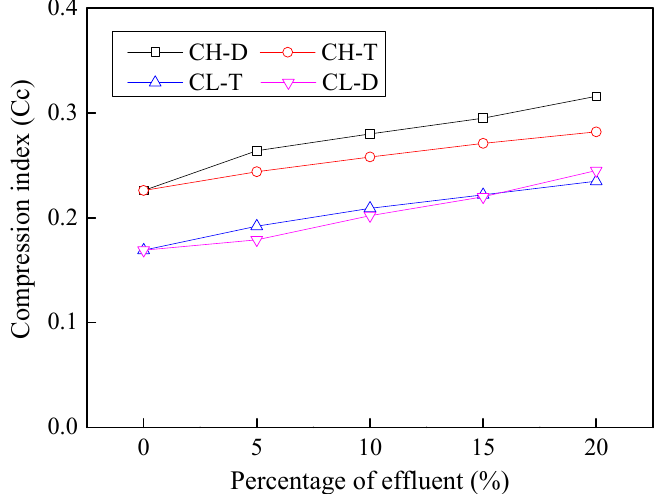
Figure 13. Effects of industrial effluents on compression index of cohesive soils.